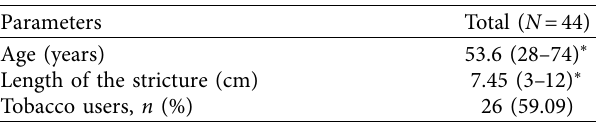
Figure 1: The marking and measurement of the preharvest buccal mucosal graft (a, b) and postharvest measurements of length and breadth (c, d). Table 1: Demographic data.